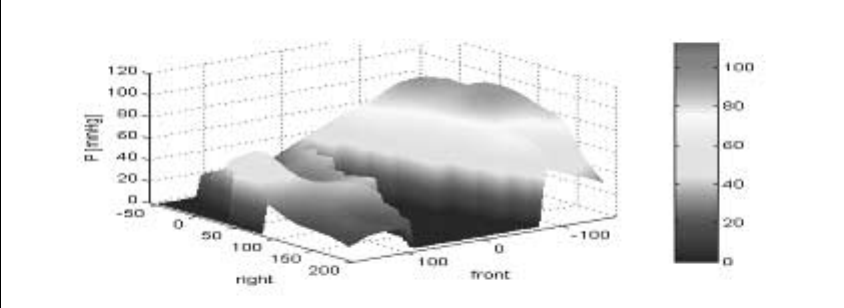
Figure 9: Silicon Gel cushion: Diagonally forward leaning (PRT2).